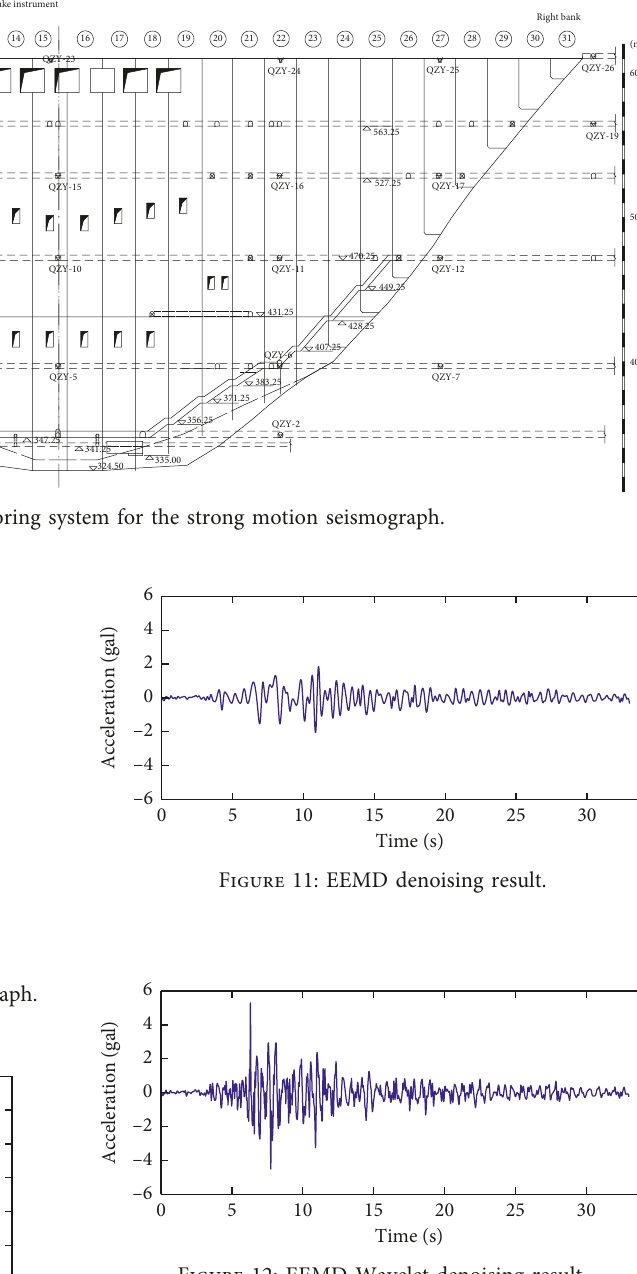
Figure 12: EEMD-Wavelet denoising result.